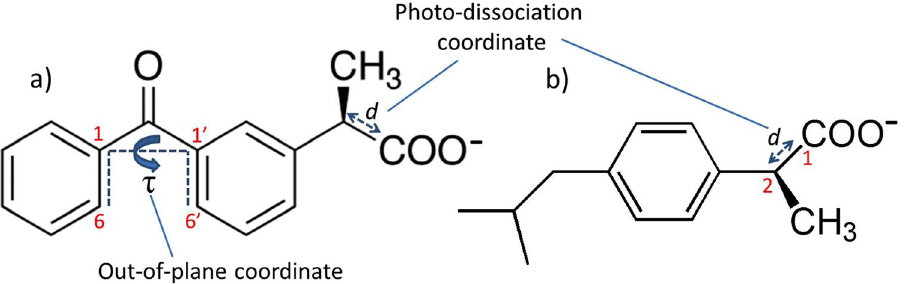
Figure 1. Molecular structures of ketoprofen ( a ) and ibuprofen ( b ). The two coordinates d and τ leading to the two different photophysical pathways are also